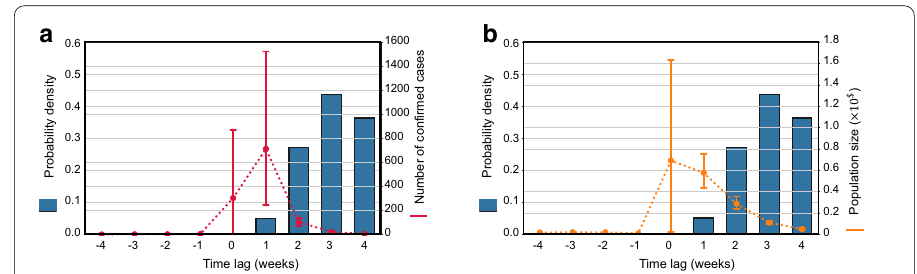
Fig. 5 Probability density function of time lags between co-location degree centrality and weekly basic reproduction numbers (blue bar plot). a With the average number of confirmed cases on March 31, 2020, for the counties in each time-lag group (line plot with error bar); and b with the population size of a county. Positive time lag indicates degree centrality decreases prior to the decrease of basic reproduction number (indicating proactive social distancing), while negative time lag indicates the basic reproduction number decreases prior to the decrease of degree centrality (indicates obeying stay-at-home orders). The error bar represents the two-side 95% confidence interval. Some extreme numbers of confirmed are considered as outliers and are not included in the analysis